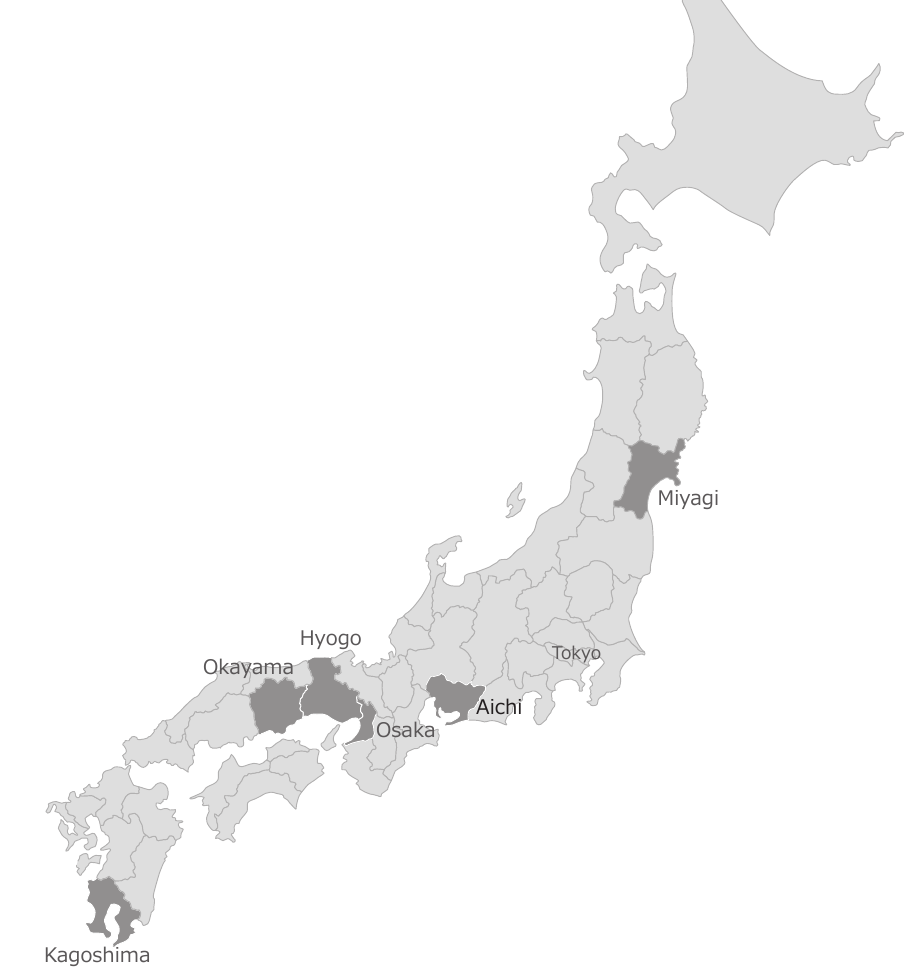
Figure 2. Geographical location of the prefectures sampled in Japan. Table 1. Questions related to lifestyles included in the ques- tionnaire used in the baseline survey Rice = Wheat